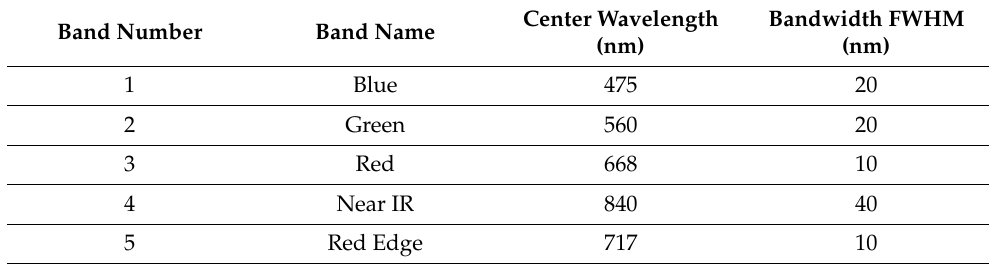
Table 1. Band specifications of the MicaSense RedEdge-M camera. RedEdge-M user manual